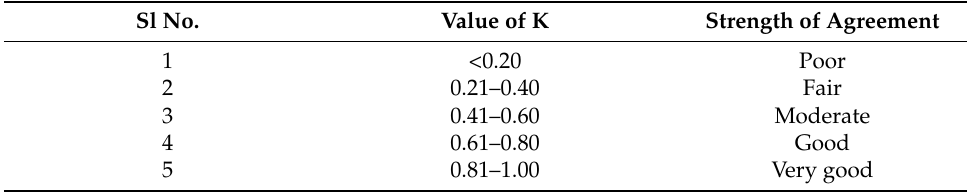
Table 2. Scale of Kappa coefficient and the strength of